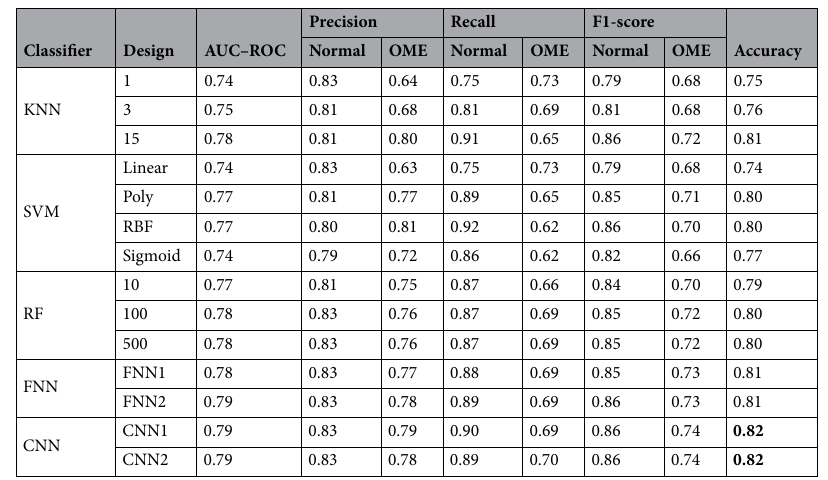
Table 1. Summary of the performance of the ML models for predicting normal middle ear condition and